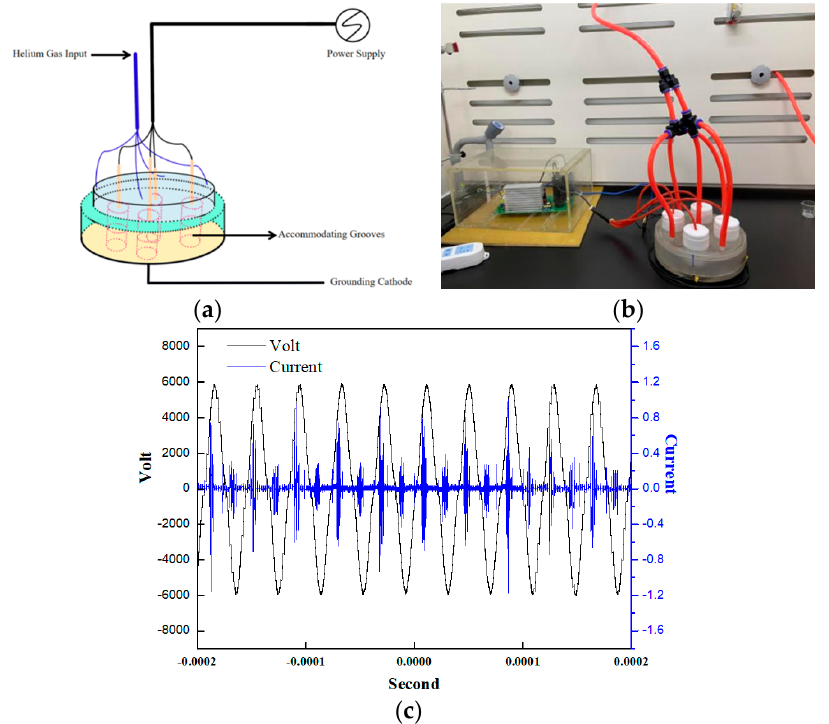
Figure 9. DBD LTP apparatus. ( a , b ) Schematic and images pictures of the DBD LTP apparatus. ( c ) Voltage and current waveforms of the LTP apparatus.